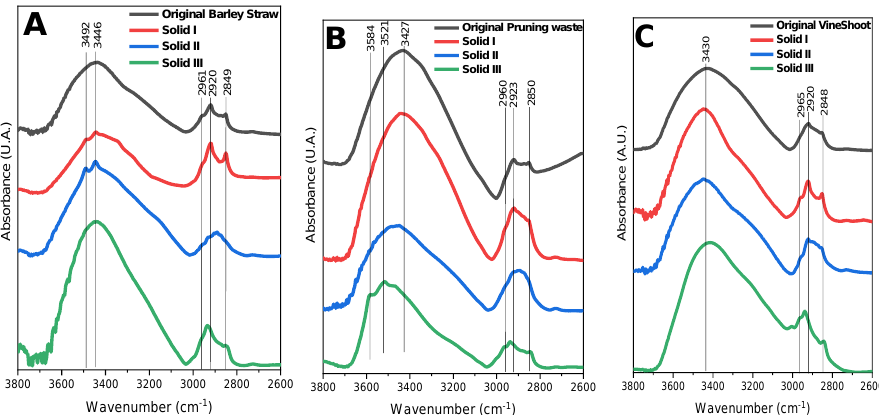
Figure 3. FTIR spectra of Solid I, Solid II, and Solid III and their corresponding lignocellulosic biomasses (( A ): Barley straw; ( B ): pruning waste; ( C ): vine shoots). Figures 4 and 5 show the spectra of the different solids obtained after treatment compared to the lignin, cellulose, and xylan references in the “fingerprint” region of lignocellulosic biomass, i.e., between 1800 and 800 cm − 1 . Figure 4 shows the spectrum of and Solid III (obtained after washing Solid II with acetone).